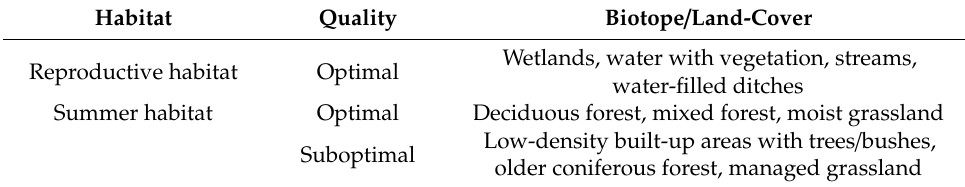
Table A2. Resource profile for the common toad according to Mörtberg et al.